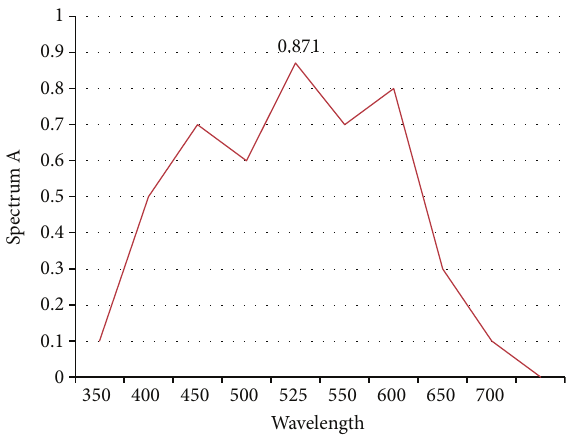
Figure 2: A schematic diagram showing KMnO 4 having a standard spectrum (absorbance 0.871 A) at wavelength 525